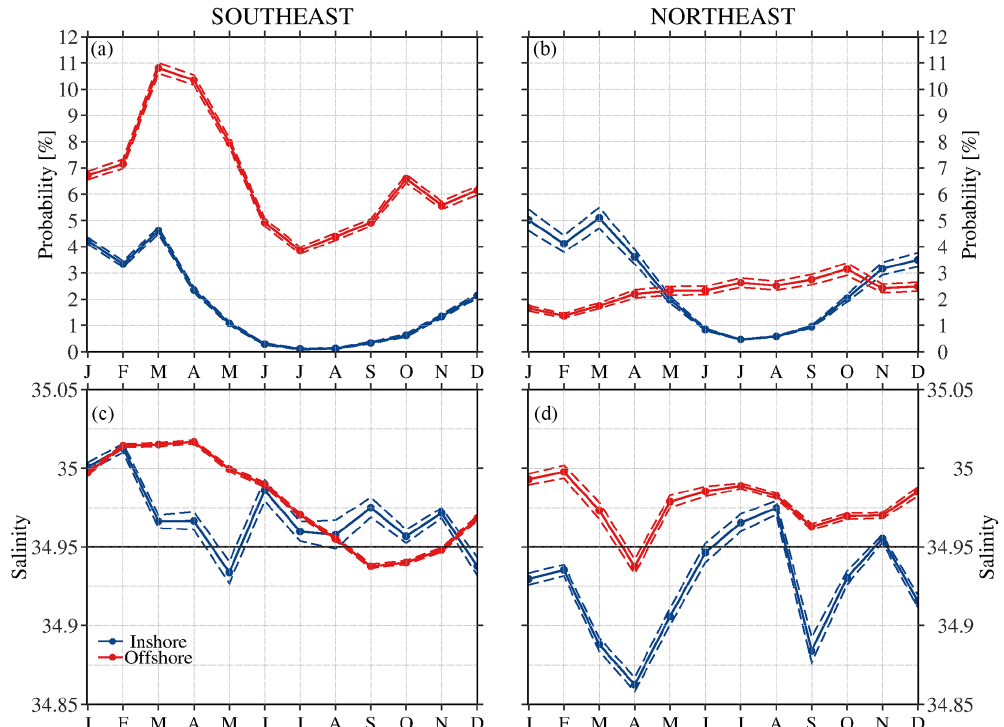
Figure 6. (a) Seasonal cycle of the probability of particles entering the basin in the southeast and (b) northeast (see Fig. 2 for the location of the regions). Seasonal cycle of salinity for particles crossing in the (c) southeast and (d) northeast. In all panels, the colors show the sources of the water: blue lines shows water from the EGC inshore region and red the water from the EGC offshore region. The dashed lines show the associated